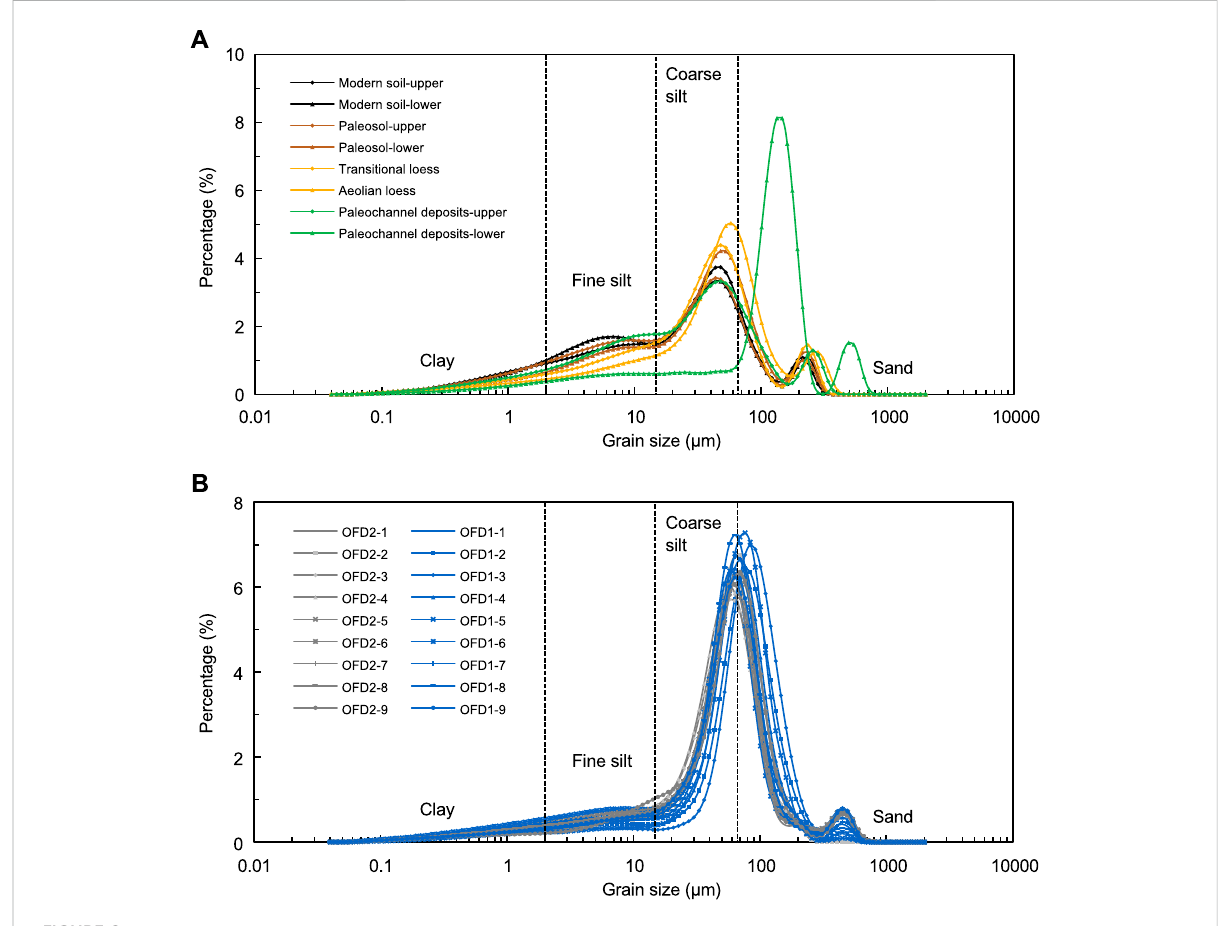
FIGURE 8 A comparison of grain size distribution frequency curves among (A) aeolian loess-paleosol deposits and Paleochannel deposits, (B) prehistoric overbank fl ooding deposits (OFD) in the CMQ pro fi le in the Yellow River source area on the NE Tibetan